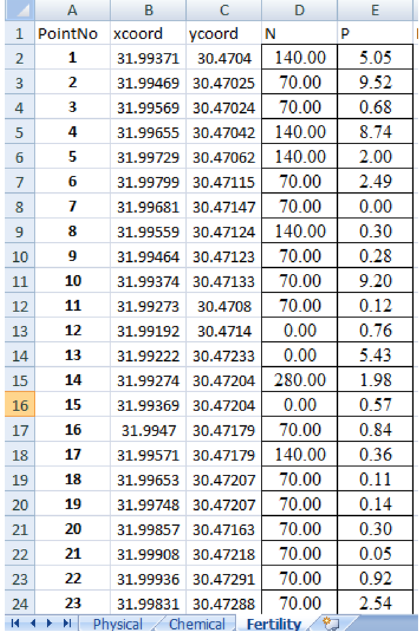
Figure 26. The acceptable format of the excel sheet data.